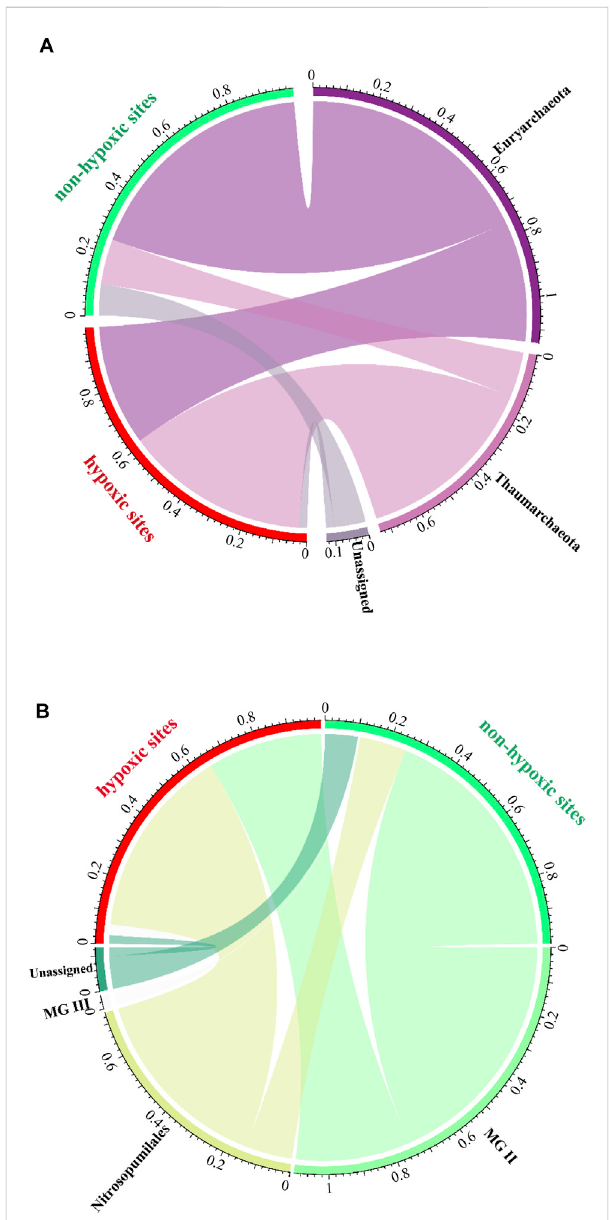
FIGURE 6 Archaeal community composition of the hypoxic and non- hypoxic zones at the phylum (A) and order (B)